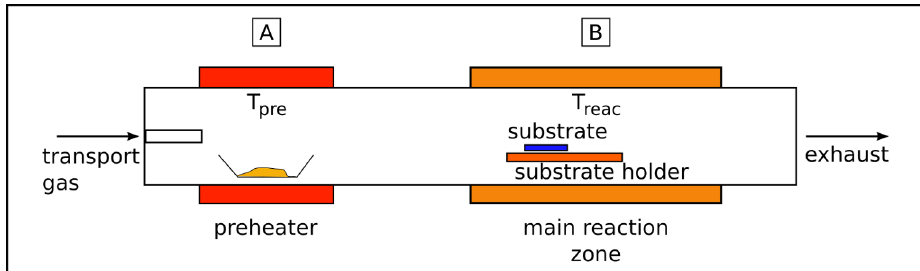
Figure 2. Setup of a typical SSCVD experiment. Ferrocene is sublimated in the preheater zone A at temperature T . The decomposition of the precursor and the formation of CNT pre occurs in the reaction zone B at temperature T . reac